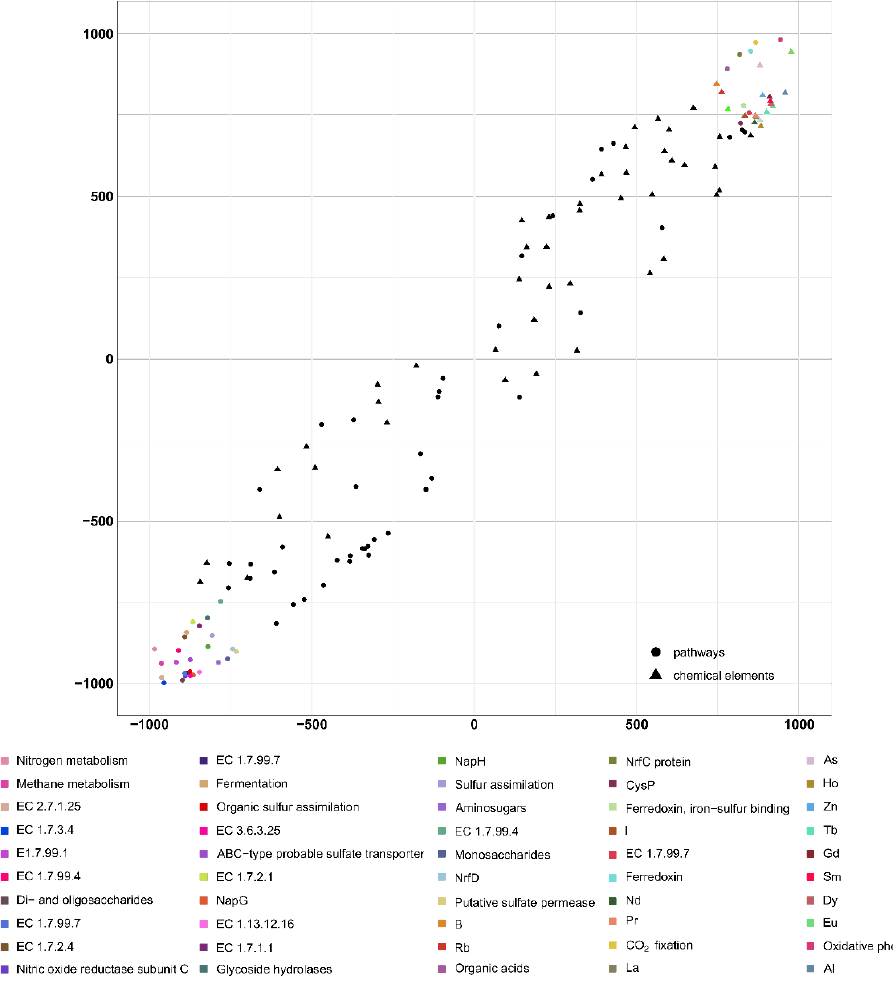
Figure 11. Results from the analysis of the second pair of datasets by the 2B-PLS method. Results on the metabolic pathways and the geochemical factors potentially affecting them. B1: Axis 1: geochemical datasets, B2: Axis 1: metabolic pathways.